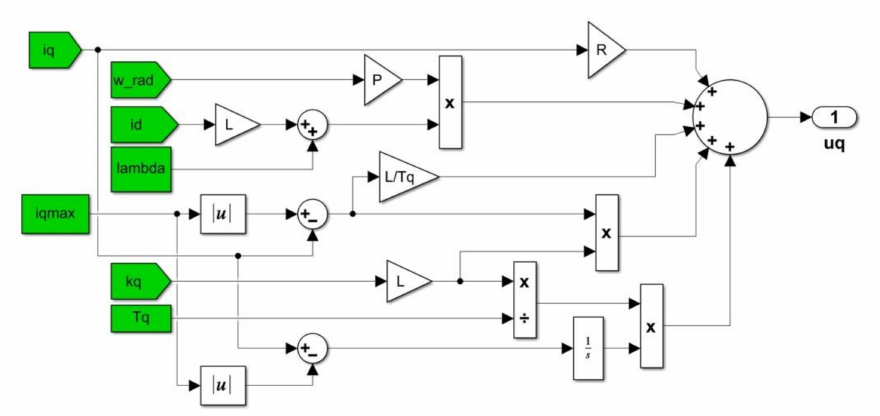
Figure 17. Block diagram of the MATLAB/Simulink implementation for the synergetic current controller of the u q command—Equation (32).